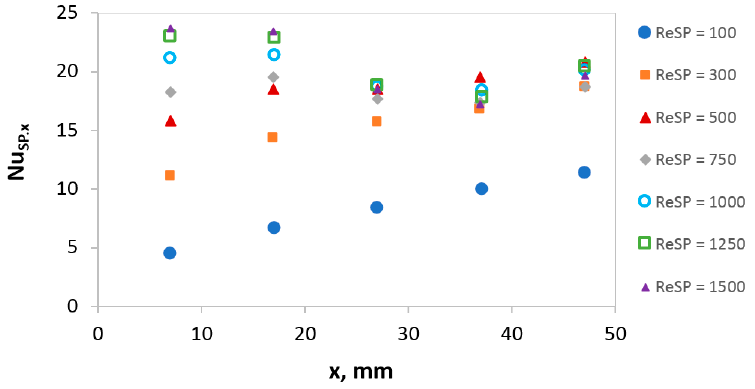
Figure 5. Dependence of the local Nusselt number on MFHE axial location for single phase flow at Re SP =